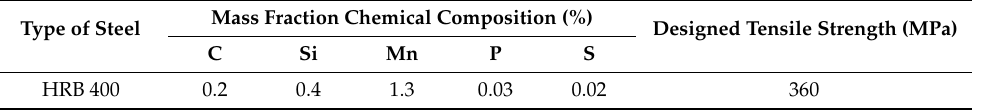
Figure 2. Steel bar covered by concrete (SBCC) specimen size design (unit: mm). ( a ) The elevation of the SBCC specimen, ( b ) the floor plan of the SBCC specimen, and ( c ) the cross section of the SBCC specimen. Table 1. Chemical composition and mechanical parameters of steel bars.